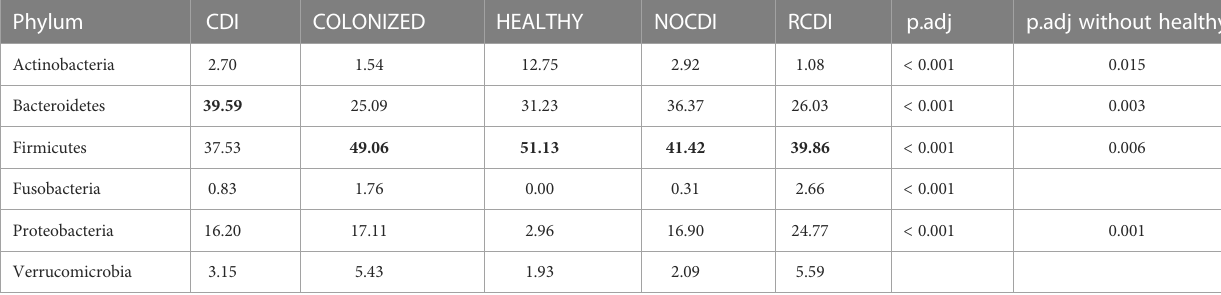
TABLE 4 Mean relative abundance (%) in each group at phylum